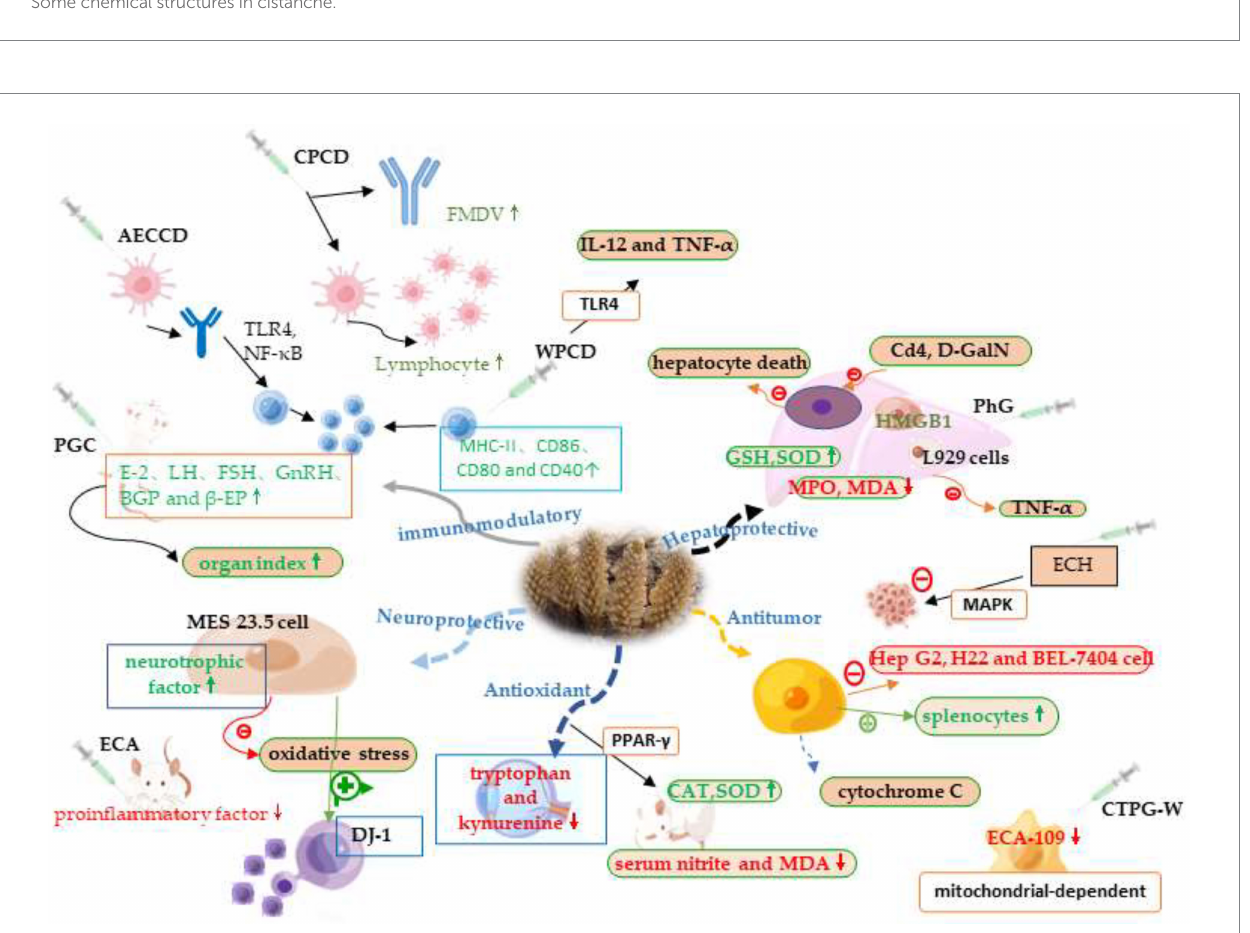
FIGURE 2 Immunomodulatory effect mechanisms of